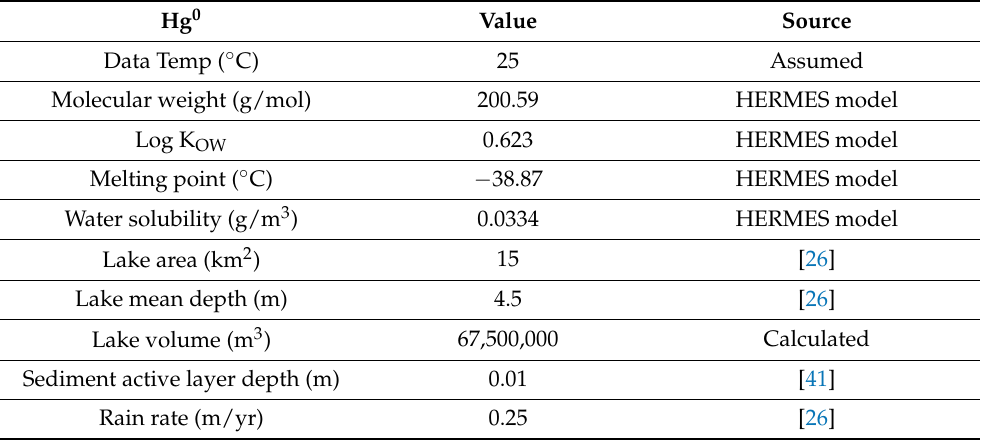
Table 1. Environmental parameters and Hg properties used in fugacity